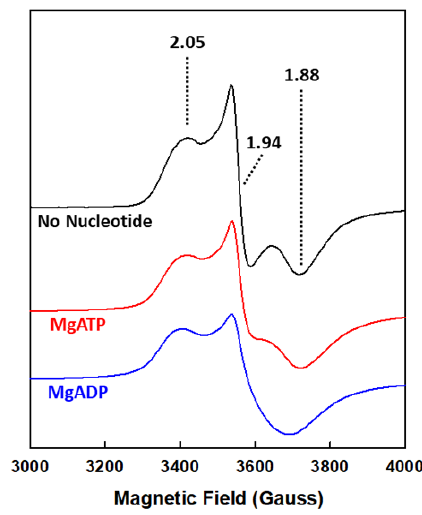
Figure 4. The nucleotide-free and bound states of NifH. Shown are the perpendicular-mode EPR spectra of the nucleotide-free (black), MgADP-bound (red), and MgATP-bound (blue) forms of NifH in the dithionite-reduced, [Fe 4 S 4 ] 1+ state. The g values are